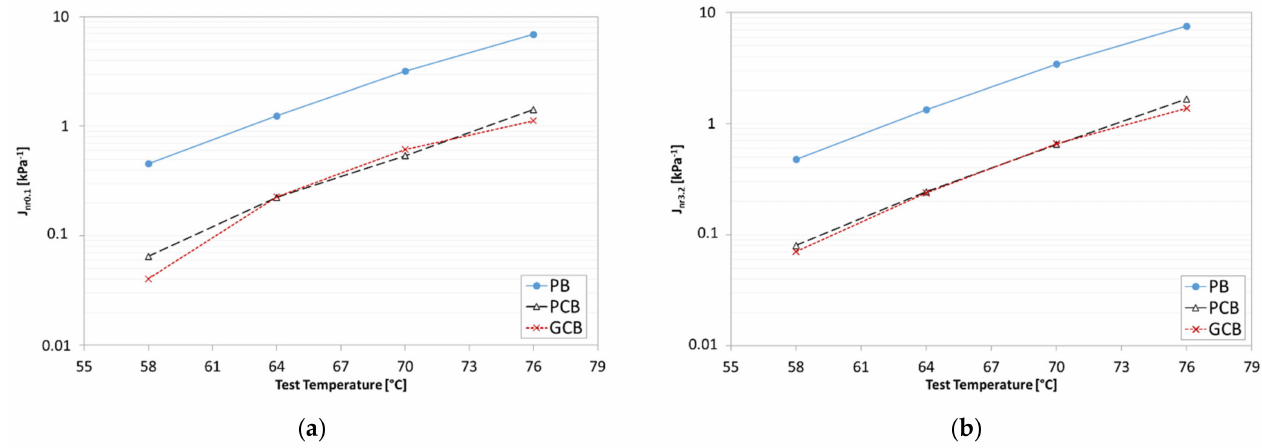
Figure 14. Nonrecoverable creep compliance of the three blends: ( a ) J nr0.1 ; ( b ) J nr3.2 . In order to evaluate the capability of the investigated blends to recover deformation, MSCR results were also analyzed in terms of average percent recovery parameters